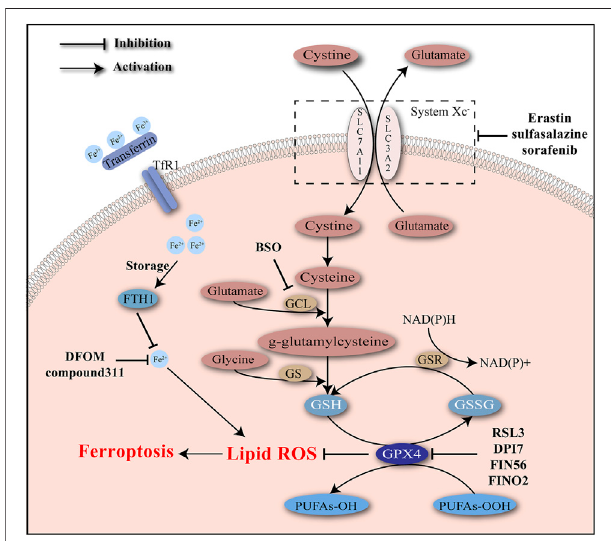
FIGURE 1 | Iron accumulation and lipid peroxidation are two critical characteristics of ferroptosis and induce oxidative damage. Ferroptosis inducers act to intervene the key molecules involved in the regulatory network of